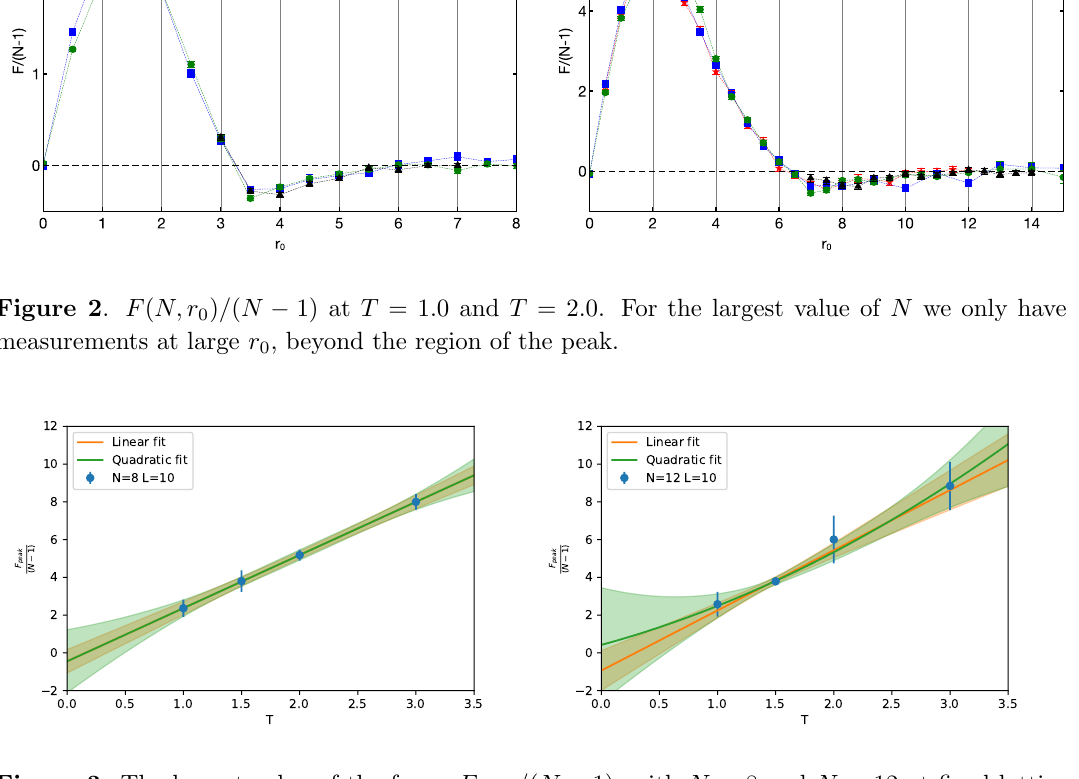
Figure 3 . The largest value of the force, F peak = ( N (cid:0) 1), with N = 8 and N = 12 at (cid:12)xed lattice spacing L =